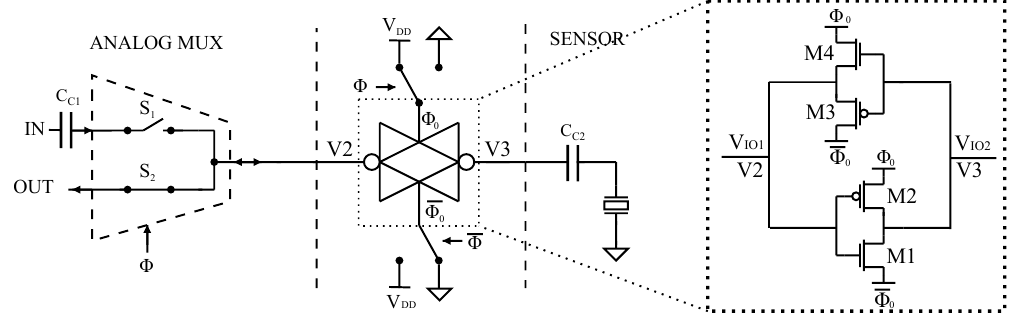
Figure 7. Proposed